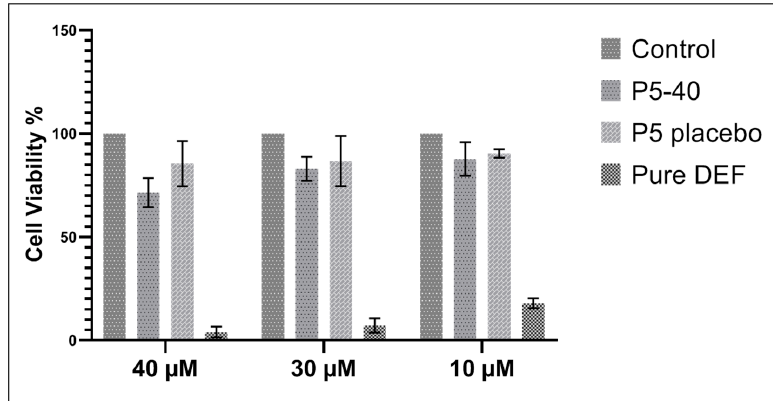
Figure 6. K562 cell viability of pure DFX, P5-40, and P5 0 formulations at different concentrations of 10, 30, and 40 μ M of DFX. ( n = 3). ( p value < 0.05).